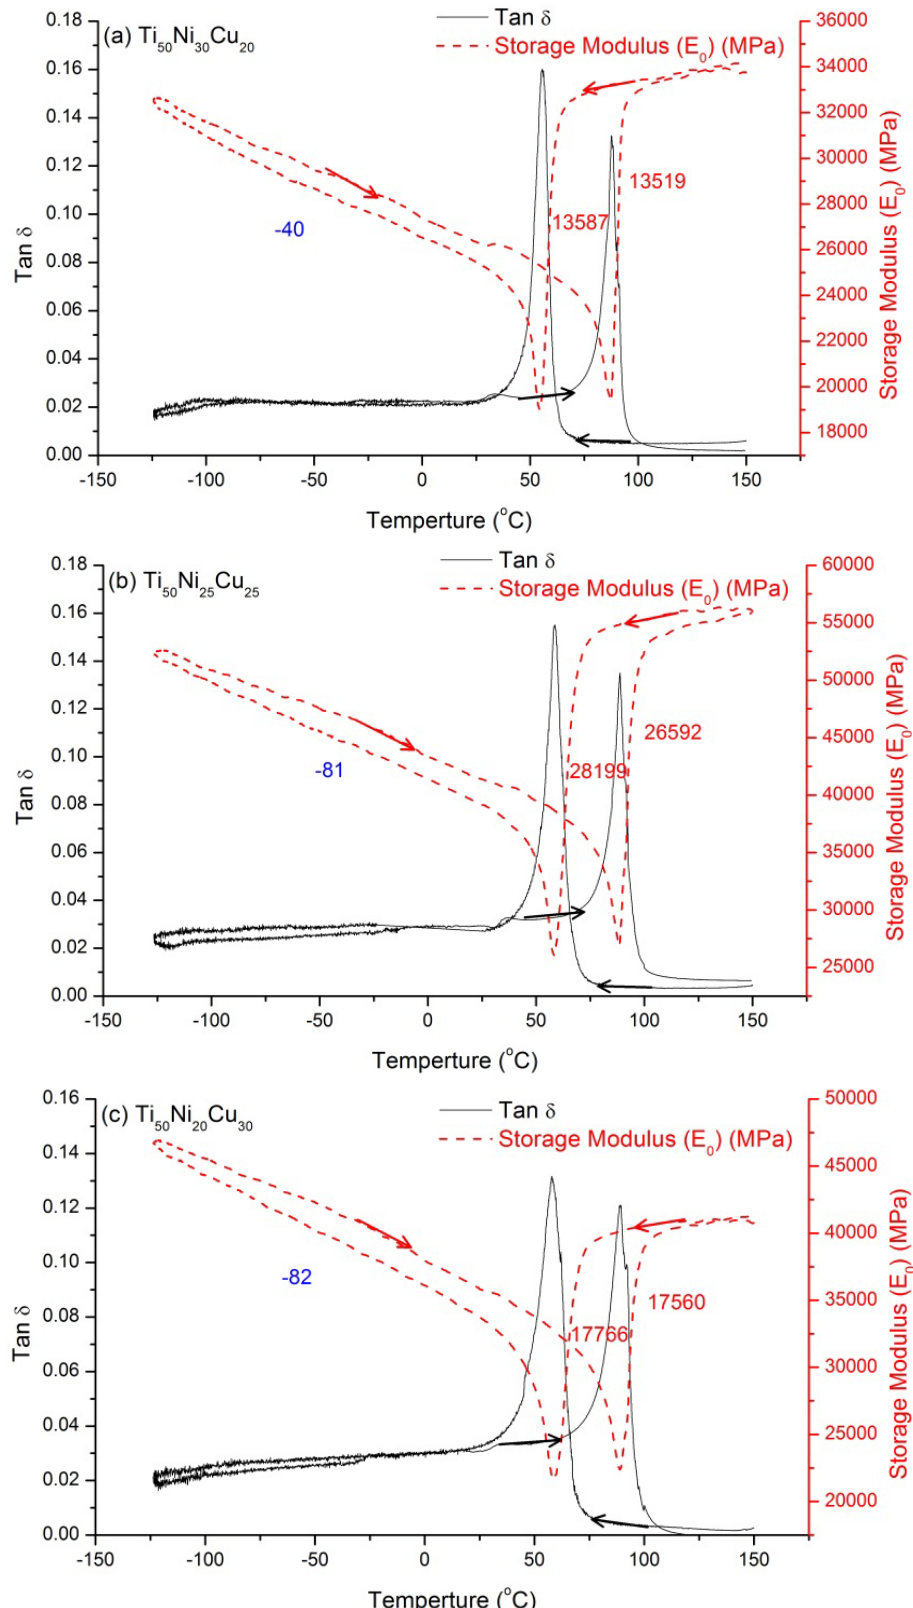
) curves for Ti Ni Cu SMAs. 0 50 50 − x x slope in B19 martensite, and 0 softening and 0